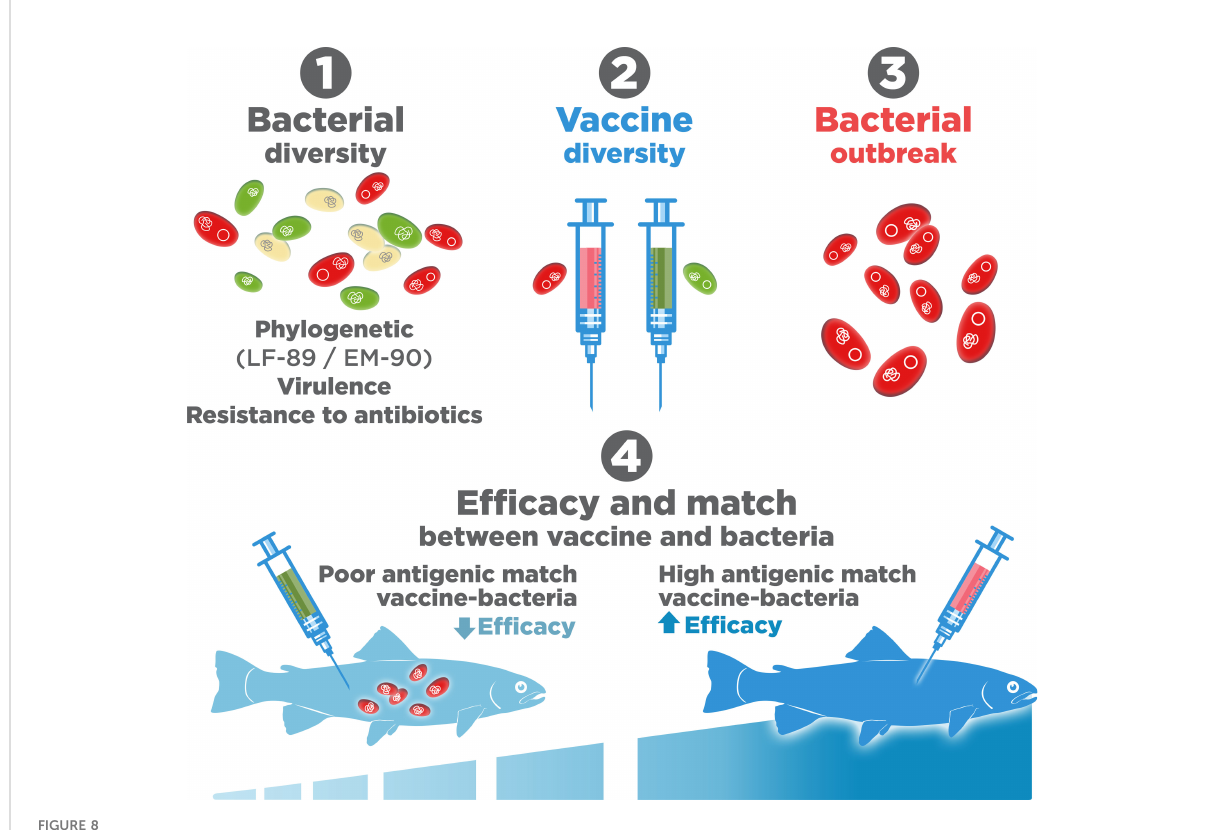
FIGURE 8 Bacterial diversity and antigenic match with